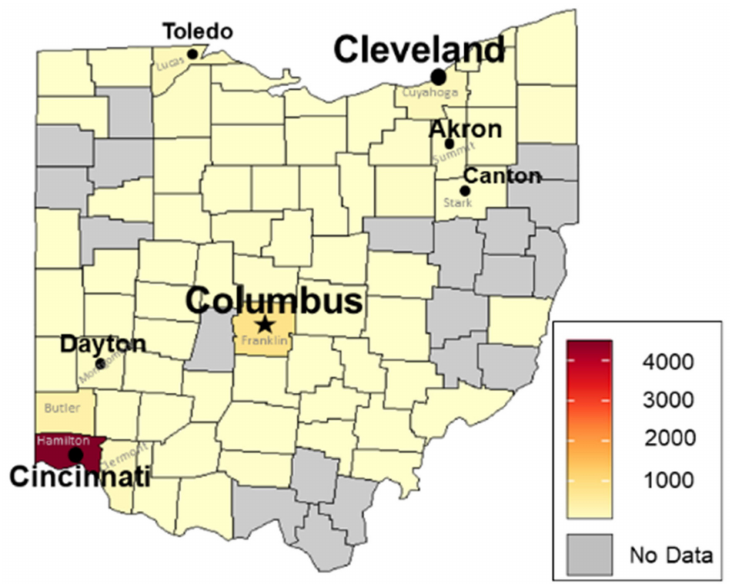
Figure 2. Heat map of estimated total number of bed bug treatments performed by licensed compa- nies in each Ohio county during 2005. As shown in the key, the darkest shade of orange red indicates a maximum threshold of approximately 4500